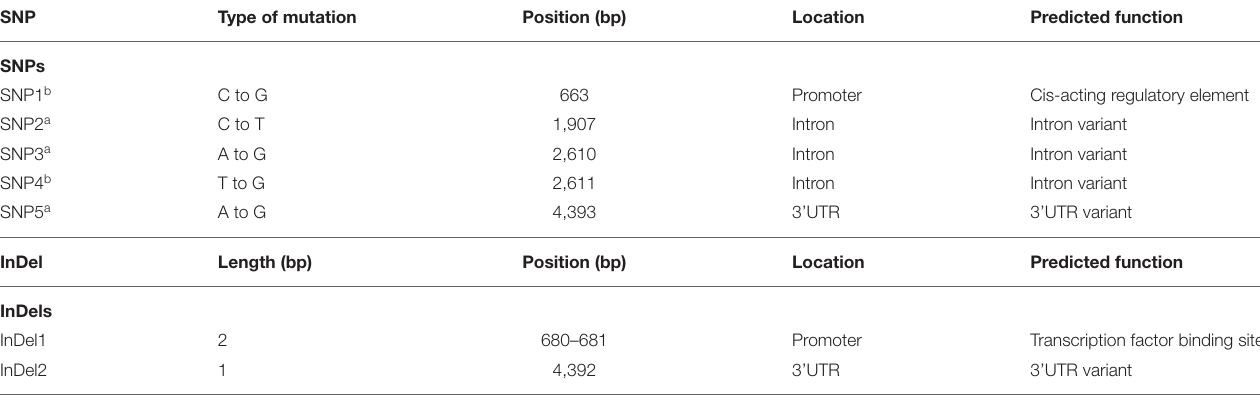
TABLE 2 | Putative SNPs and InDels clearly differentiate mutant and wild type maize inbreds.